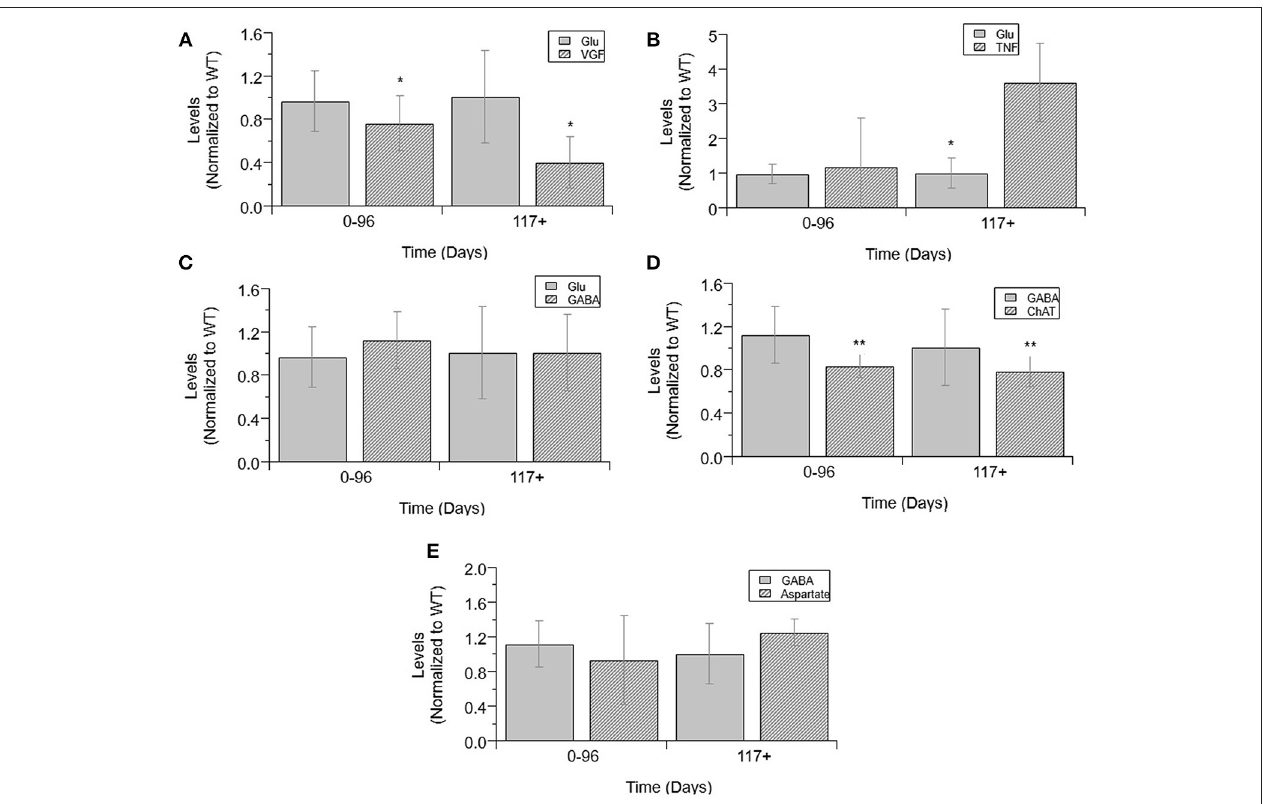
FIGURE 6 | Cytokine levels compared to glutamate and GABA levels in mixed cultures over ALS disease progression . VGF (A) , TNF α (B) , GABA (C) , and glutamate (D) averages normalized to wild-type (ratio presented as transgenic/WT) in three temporal stages: 0-96 days, 97-116 days, and 117 + days. ChAT activity (D) , aspartate (E) , and GABA average normalized to wild-type (ratio presented as transgenic/WT) in two temporal stages: 0–96 days and 117 + days, as insufficient data was available for 97–116 days. VGF levels were significantly decreased from glutamate levels at both stages (* p < 0.05). TNF α levels were significantly increased from glutamate levels at 117 + days (* p = 0.0018). GABA levels were significantly decreased from ChAT levels at 0–96 days (** p = 0.0033) and at 117 + days (** p = 0.009). Error bars represent